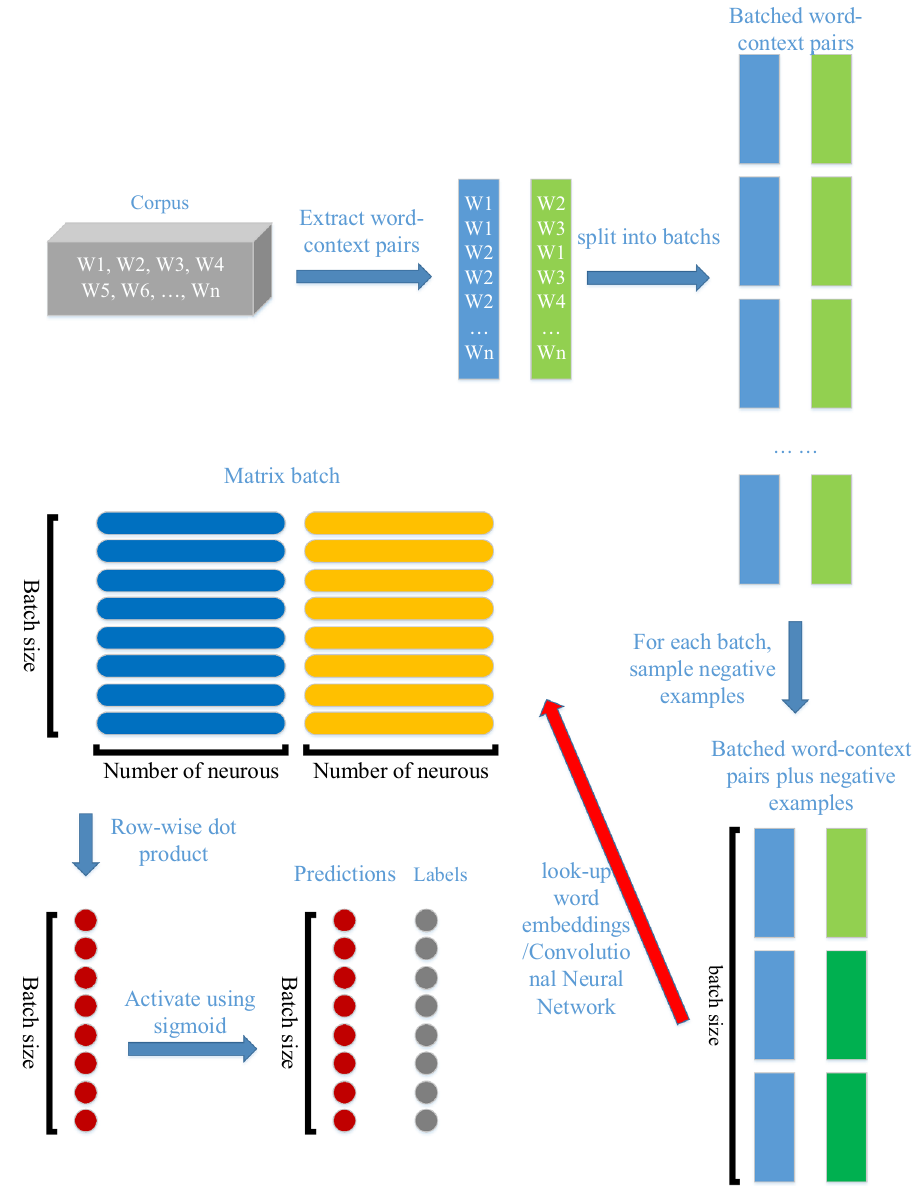
Fig. 2 Illustration of Skip-Gram with negative sampling in Chainer framework (W2V- Vanilla